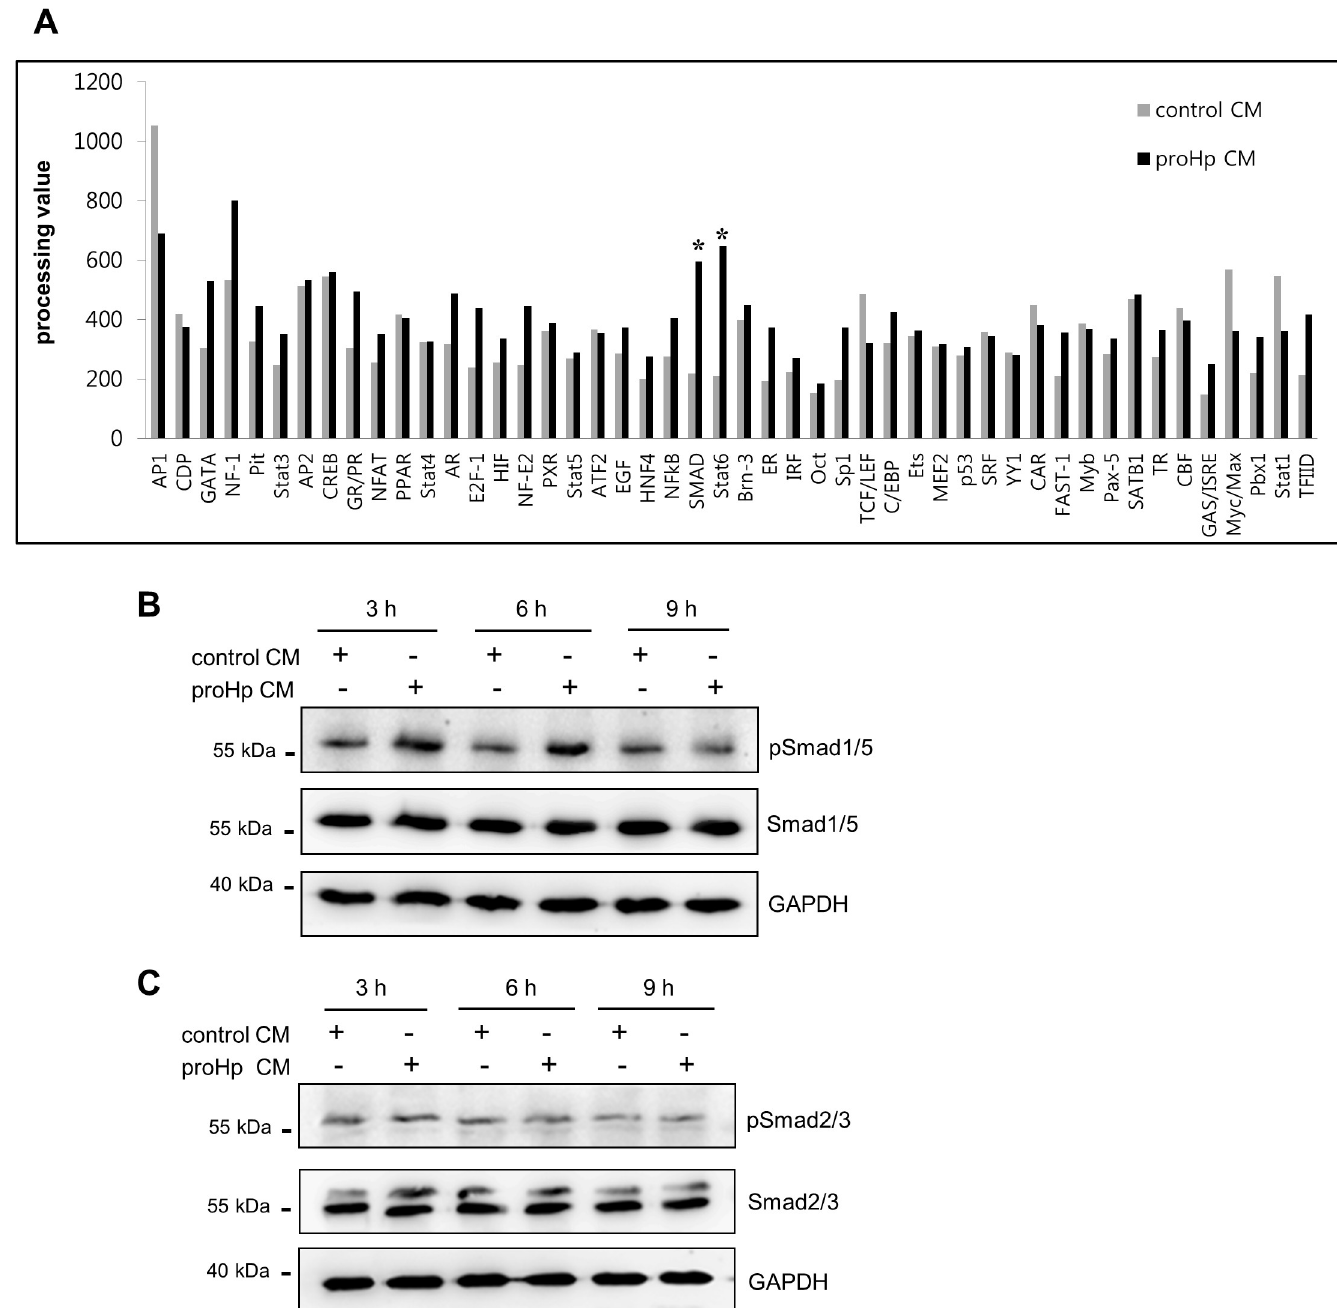
Fig 3. Smad as proHp-inducible transcription factors. (A) HUVECs were incubated for 14 h with proHp CM (final 0.2 μ g/ml proHp) or control CM in serum-free EBM-2 medium. Nuclear fractions were extracted and subjected to a transcription factor profiling assay as described in the Materials and methods. (B and C) After 3 h of serum starvation, HUVECs were stimulated with proHp CM (final 0.2 μ g/ml proHp) or control CM in serum-free EBM-2 medium. At the indicated times, phospho-Smad1/5 (B) and phospho-Smad2/3 (C) in cell lysates were detected by western